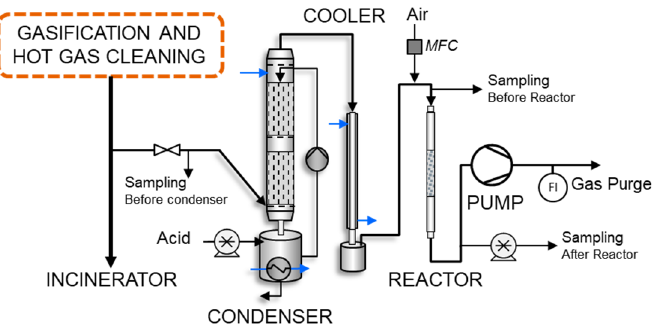
Figure 1. Schematic illustration of bench-scale fixed-bed adsorption unit connected to gasification facility slipstream consisting of a condenser, cooler, adsorbent reactor, and